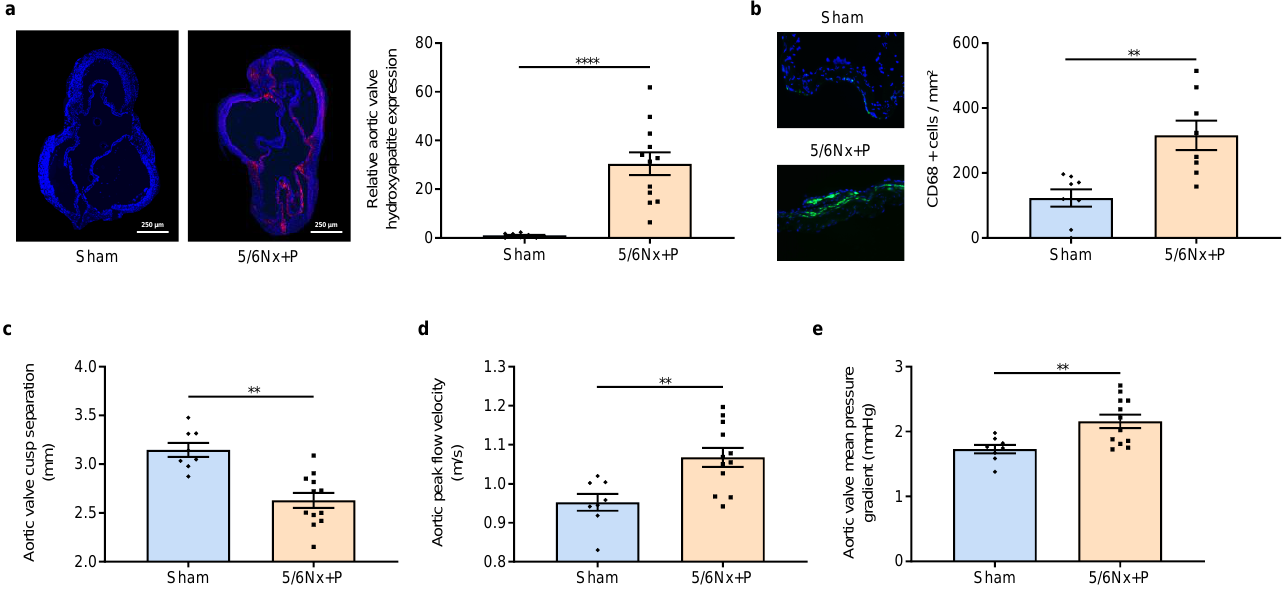
Figure 3. Representative images and relative values of hydroxyapatite expression of aortic valves stained with Osteosense 680Ex ® ( a ), representative images and values of CD68+ cells per mm² (green and blue staining represent CD68+ cell and DAPI nuclear marker, respectively) ( b ), aortic valve cusp separation ( c ), peak flow velocity ( d ), and mean pressure gradient ( e ) obtained 10 to 11 weeks after surgery in sham-operated and 5/6 nephrectomized rats receiving a high-phosphate diet (5/6Nx + P). ** p < 0.01, **** p < 0.0001.